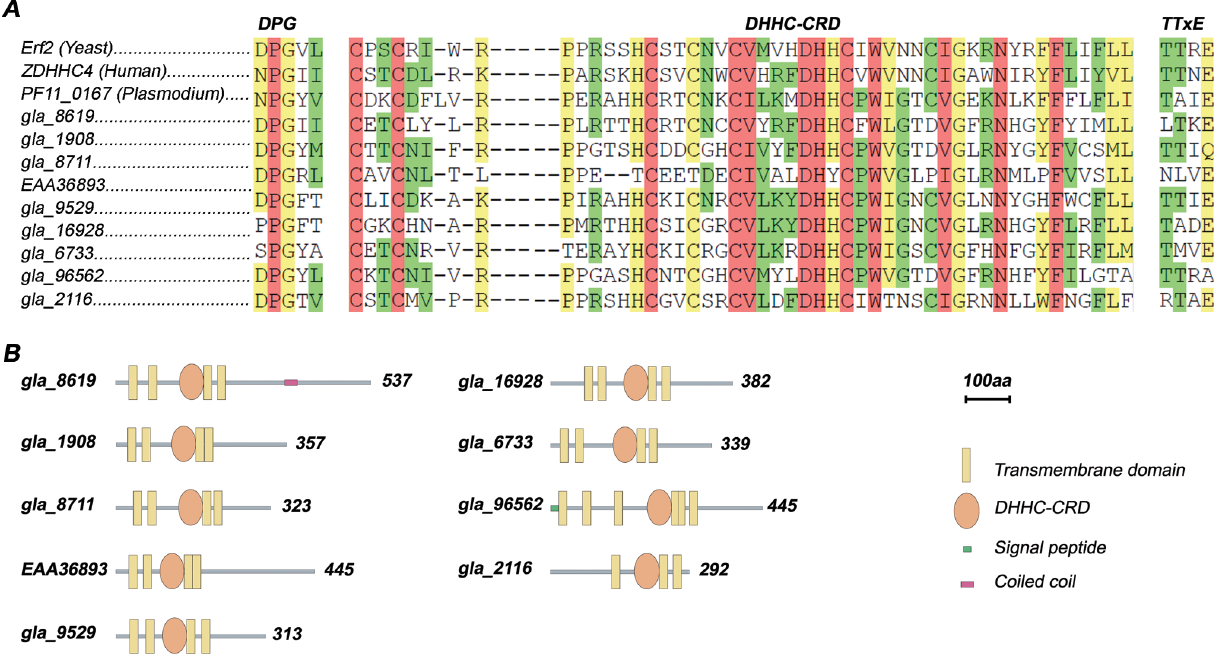
Figure 3. Sequence alignment and schematic drawing of Giardia DHHC proteins. (A) Multiple Sequence alignment of DHHC proteins shows conserved regions. The amino acid sequences of the total set of Giardia DHHC proteins, Erf2 (Yeast), ZDHHC4 (Human), and PF11_0167 ( Plasmodium falciparum ) were aligned using T-Coffee software [104]. The conserved DHHC-CRD domain and the DPG and TTxE motifs are indicated in bold. Positions exhibiting absolute identity are shown in pink, and high and lower amino acid similarities in green and yellow, respectively. (B) Schematic representation of the primary structure of Giardia DHHC proteins. The domains were searched using SMART (http://smart.embl-heidelberg.de) [105], [106]. Transmembrane domains were predicted using TMHMM (http://www.cbs.dtu.dk/services/TMHMM) [107] and TMPred (http://www.ch.embnet. org/software/TMPRED_form.html) with default settings. Signal peptides were predicted with signalP (http://www.cbs.dtu.dk/services/SignalP) [108].